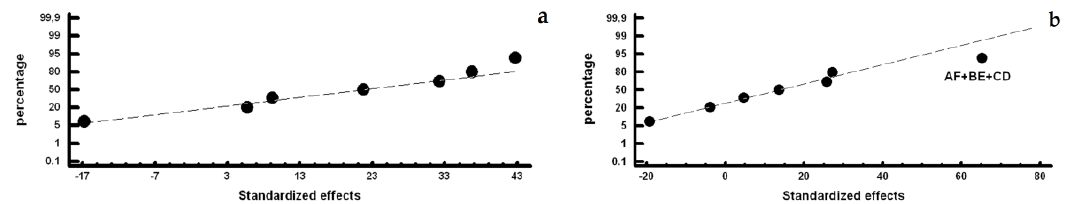
Figure 3. Representation of standardized effects on a normal probability plot versus Vickers hardness: ( a ) Region I and ( b ) Region II.